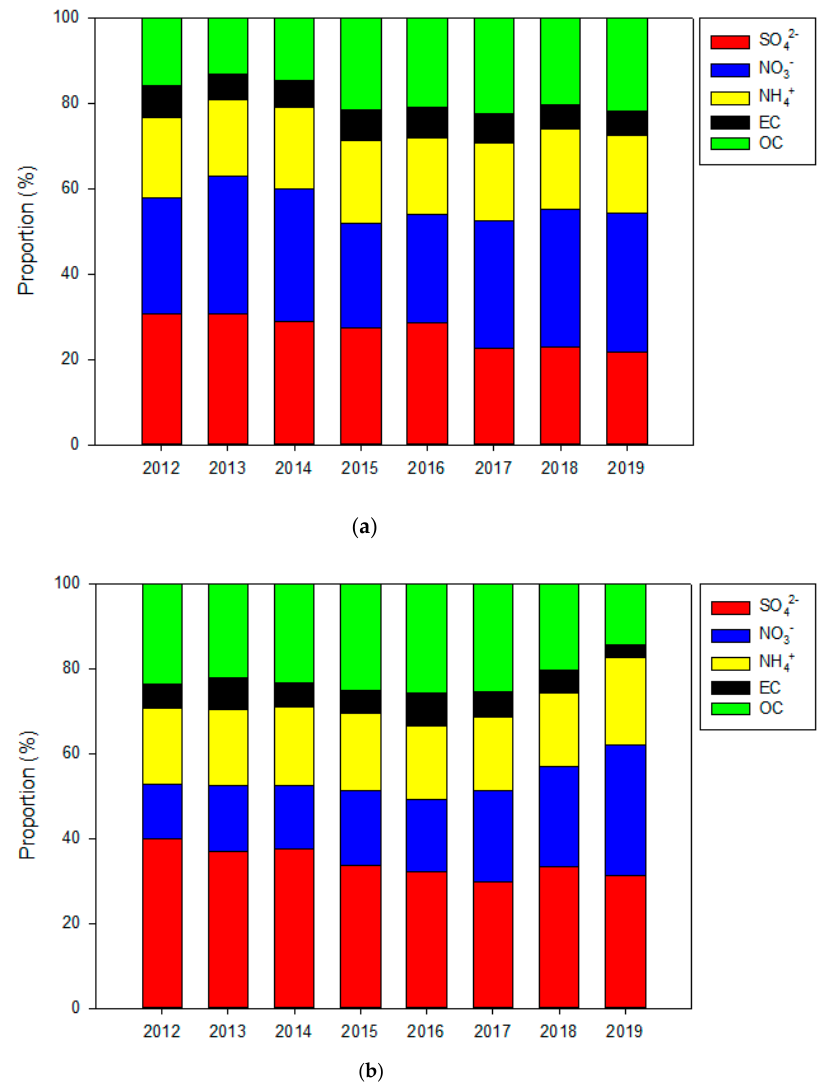
Figure 4. Changes of the proportions of major aerosol species in PM2.5: ( a ) Seoul; ( b ) Baengnyeong Island. 3.4. SOR and NOR in Seoul and on Baengnyeong Island According to PM2.5 Concentration and